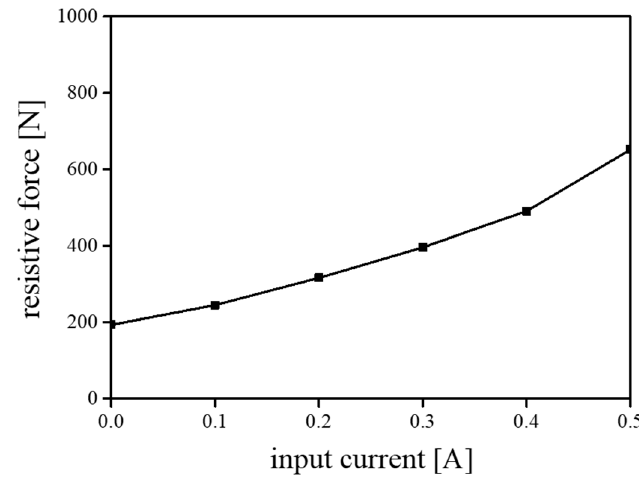
Figure 7. Simulated resistive force as a function of input current.